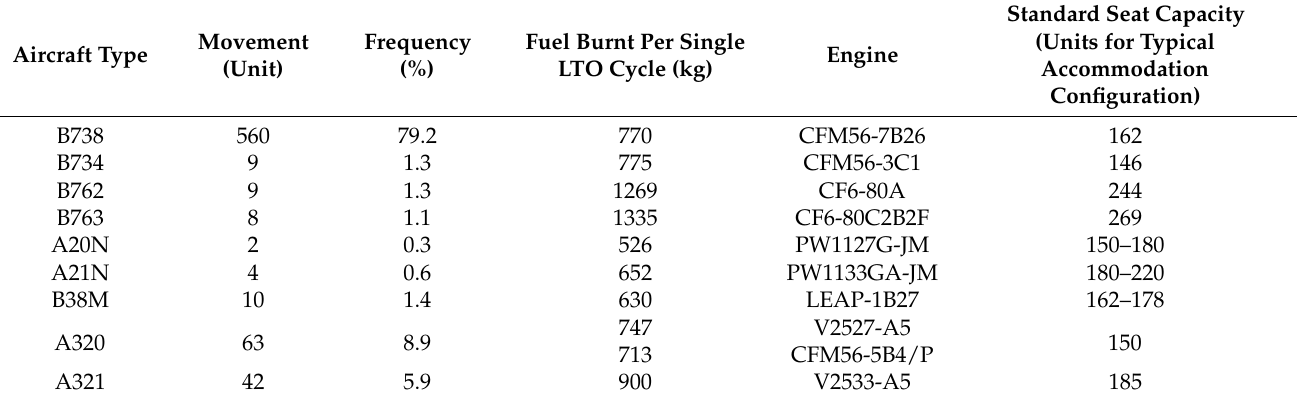
Table 2. Typical data collected to describe monthly average traffic, September 2021 as an example.